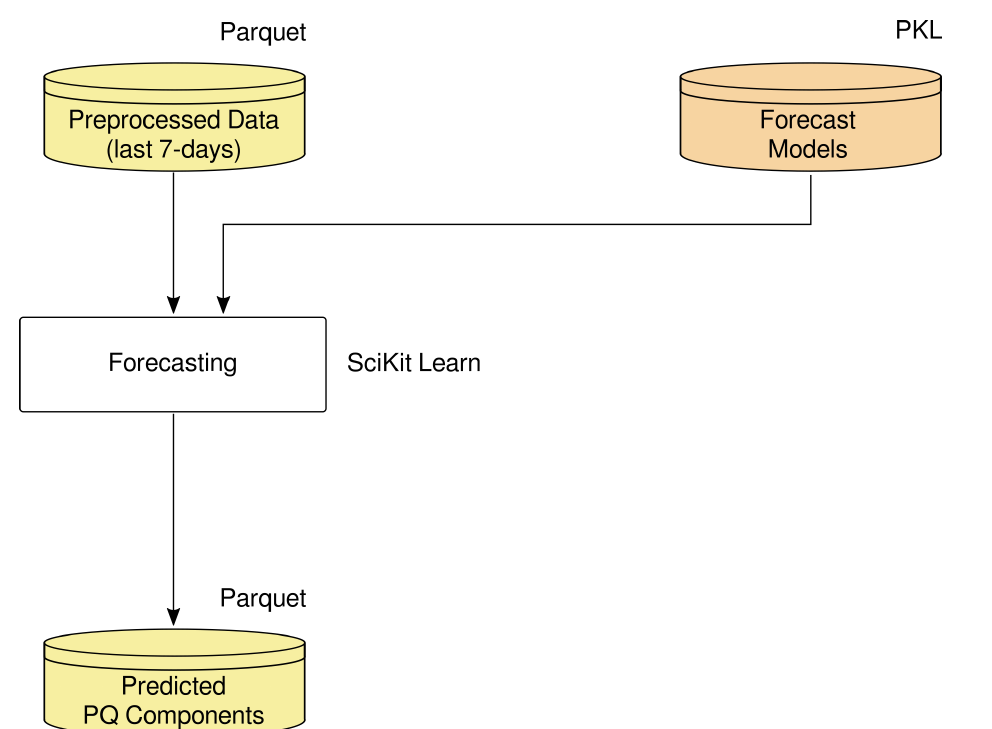
Figure 5. Forecasting component of MIRD. Nearly 4000 univariate forecasting models persist as SciKit Learn Pickle files. Input features and predictions persist as Parquet